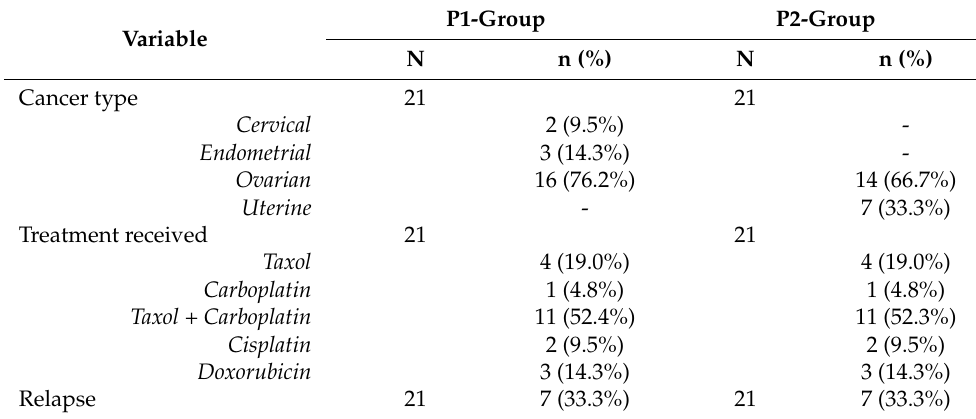
Table 2. Descriptive statistics of clinical characteristics in the P1 and the P2 groups.